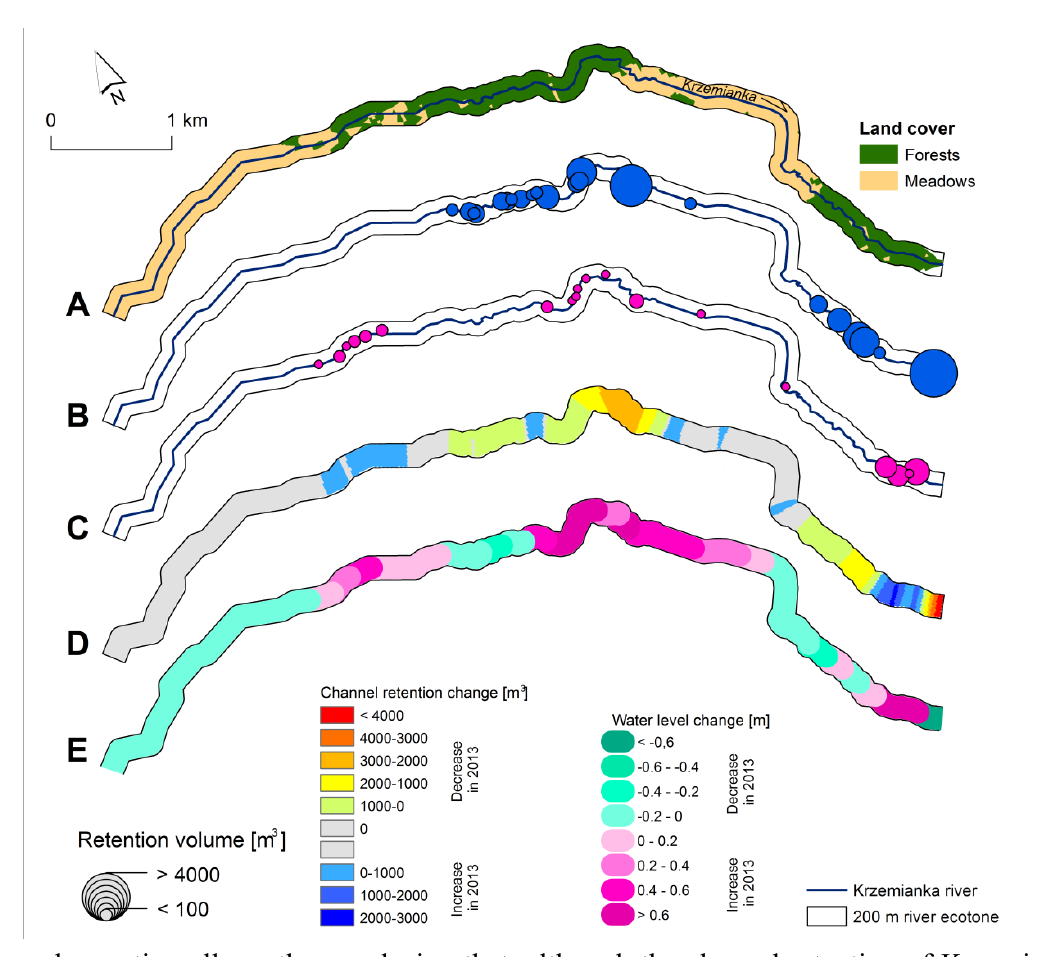
Figure 3. A —land cover of the 200 m ecotone of Krzemianka river; B —distribution of beaver ponds and their retention capacities in August 2006; C —distribution of beaver ponds and their retention capacities in August 2013; D —channel retention change (2013 comparing to 2006); E —water level change (2013 comparing to